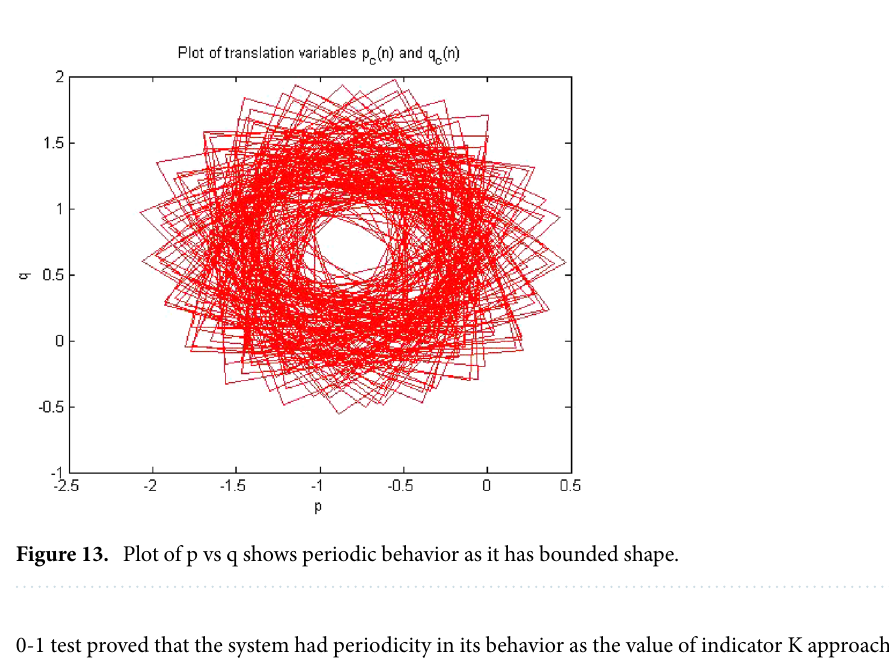
Figure 12. MSD vs time plot there is no asymptotic growth, so the dynamics is regular.